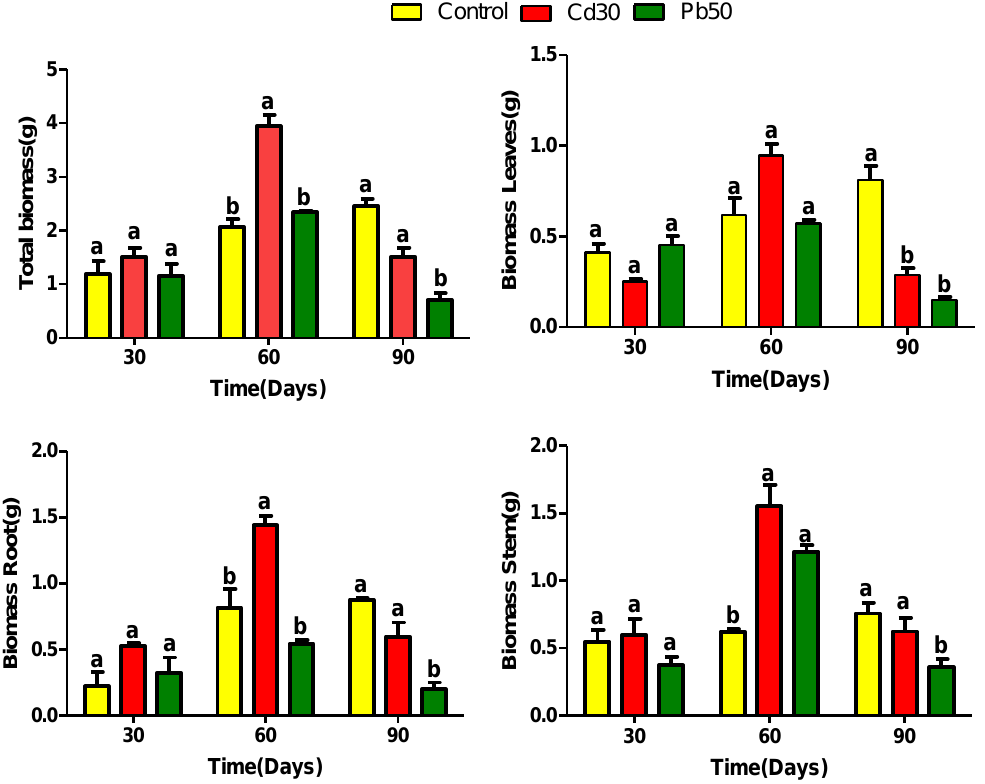
Figure 1. Amount of dry biomass in di ff erent tissues of Paspalum fasciculatum exposed to Cd and Pb in mining soils. Treatments Pb50 = 50 mg kg − 1 Pb, Cd30 = 30 mg kg − 1 Cd, ( n = 3). The letters are the statistical significance ( p < 0.05) between the control and treatments-Cd30 and Pb50.